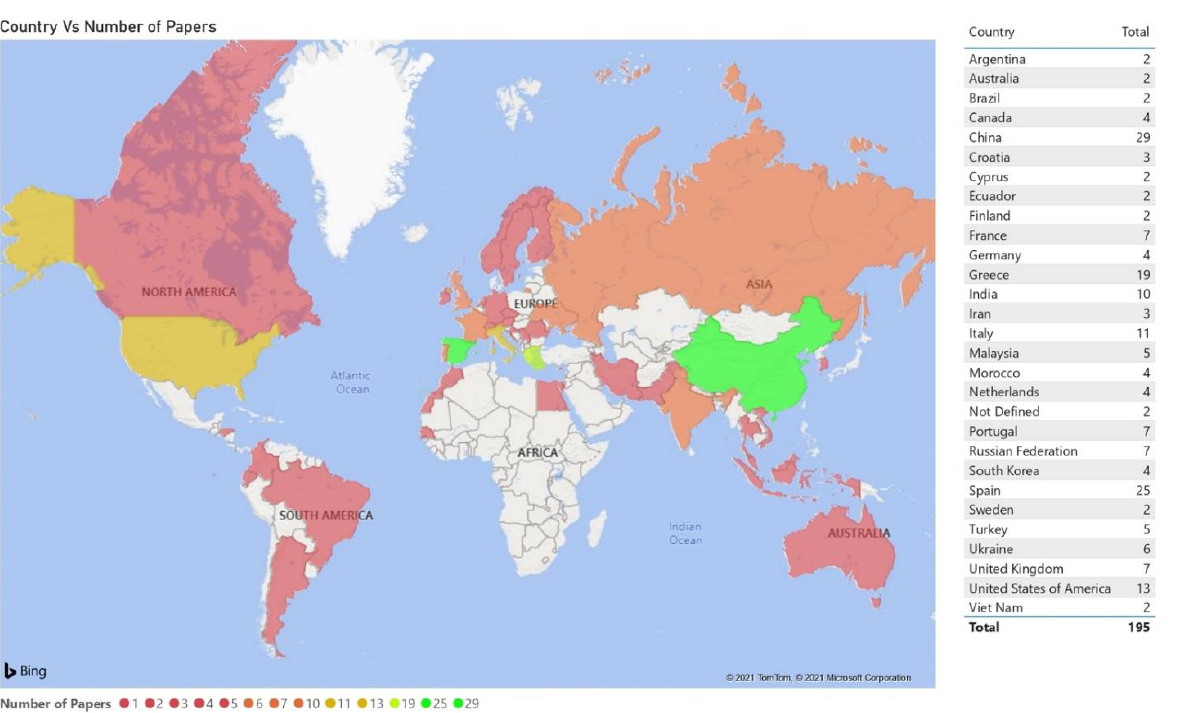
Figure 12. Papers selected by country.